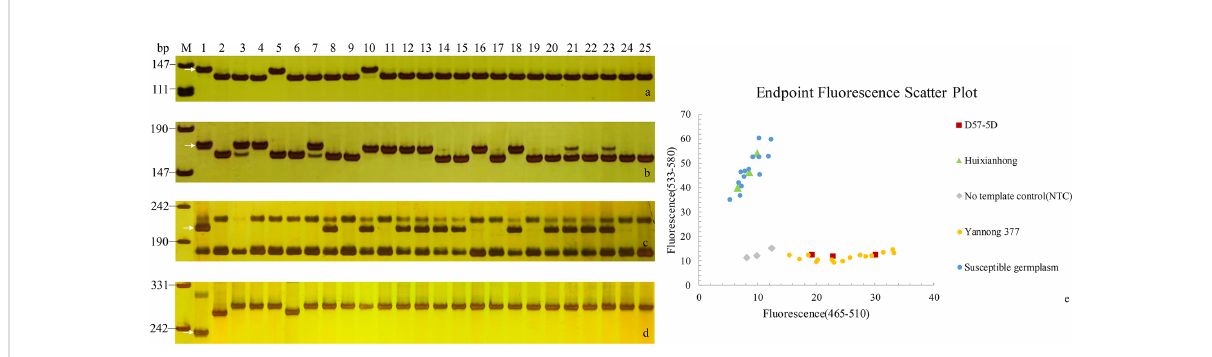
FIGURE 3 PCR ampli fi cations of speci fi c markers Pm2b-map-3 for Pm2 (A) , Xicssl795 for Pm52 (B) , SC200 for Yr10 (C) and Y15K1-F2/UHW301R for Yr15 (D) in 23 Yannong series wheat cultivars/lines. M, pUC19; 1: Positive control; 2: Negative control; 3-25: Yannong 30, Yannong 37, Yannong 377, Yannong 15, Yannong 17, Yannong 23, Yannong 24, Yannong 31, Yannong 161, Yannong 191, Yannong 215, Yannong 301, Yannong